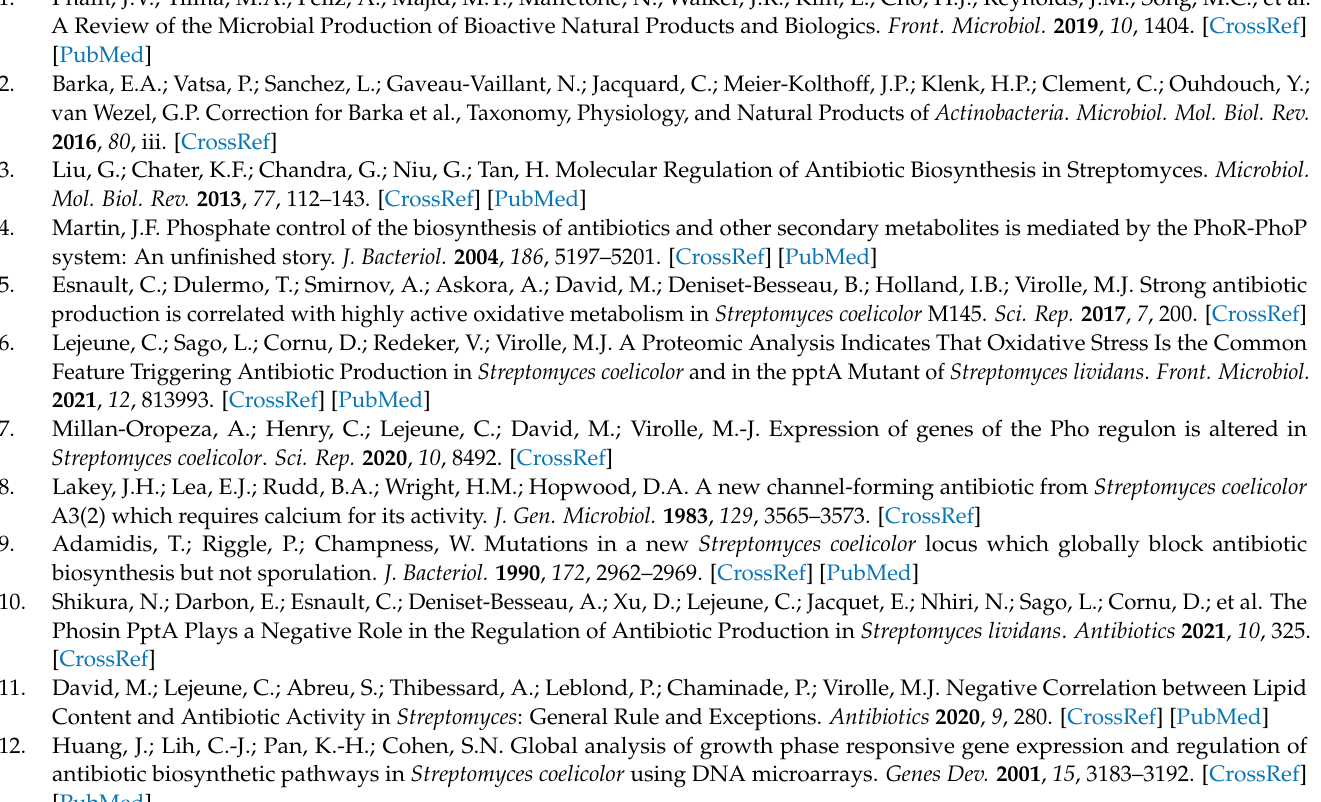
Table S1: List of oligonucleotides used in this